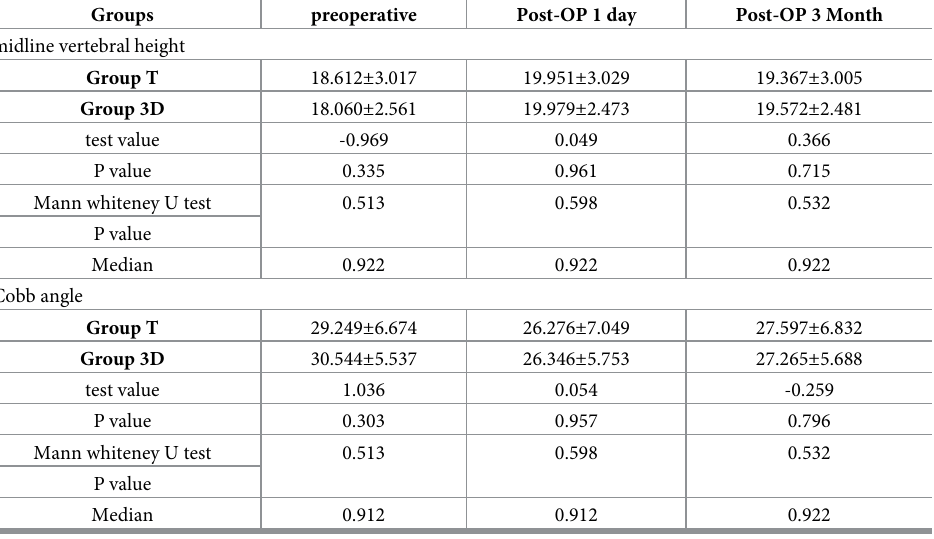
Table 4. Midline vertebral heights and Cobb